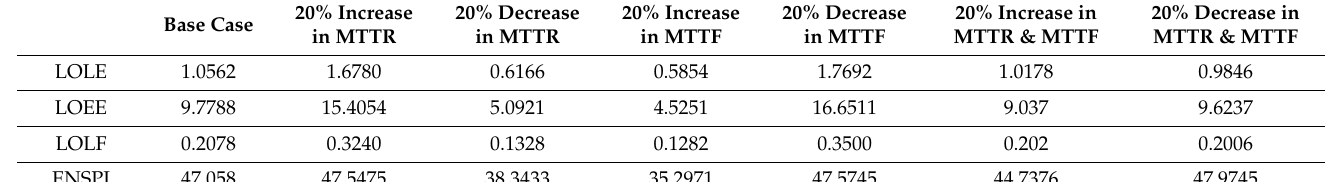
Table 4. Reliability indices for different MTTR and MMTF values with 0% BEV penetration.